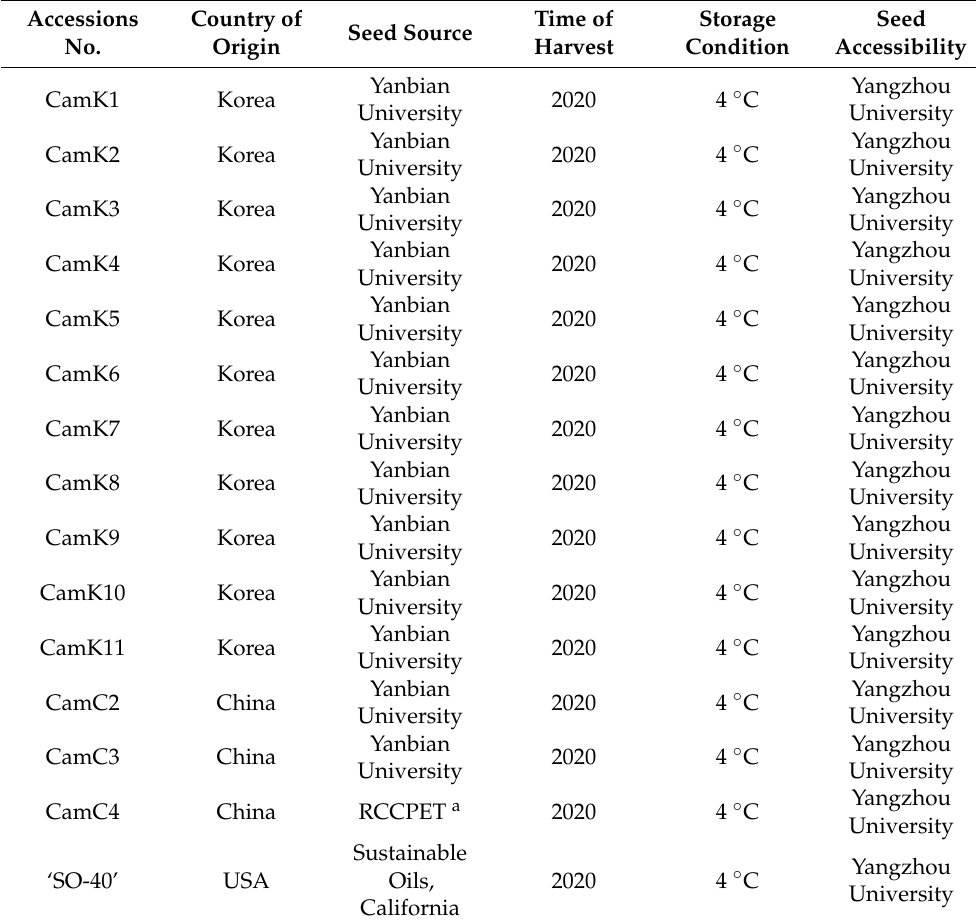
Time of Storage Harvest Condition